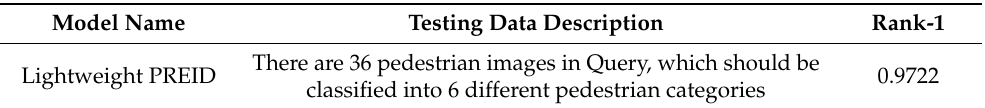
Table 4. Pedestrian re-identification model